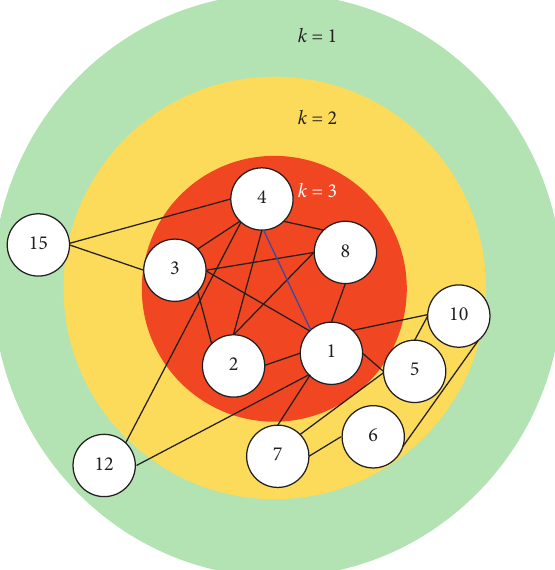
Figure 2: A k -shell layered diagram with nodes 9, 11, 13, and 14 deleted. Table 1: Basic topological features of the four networks.